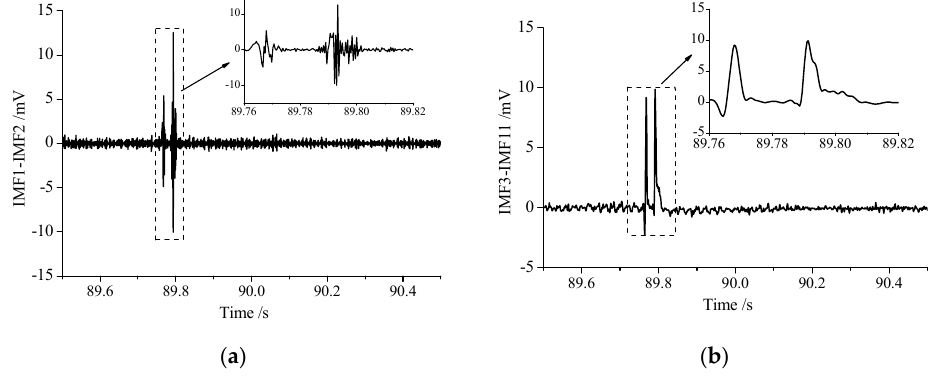
Figure 10. High-frequency and low-frequency components of MS in 89.5–90.5 s at the I stage. ( a ) High-frequency component and ( b ) low-frequency component.